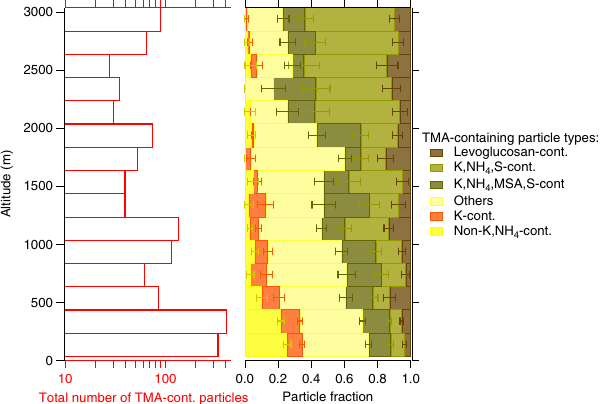
Figure 11. Cumulative vertically resolved aerosol composition of TMA-containing particle sub-types (normalized to the total number of TMA-containing particles (indicated by red bars)): “K,NH 4 ,MSA,S-containing” (dark green), “K,NH 4 ,S-containing” (light green), “K-containing” (orange), “Non-K,NH 4 -containing” (yellow), “levoglucosan-containing” (brown) and “others” (light yellow).